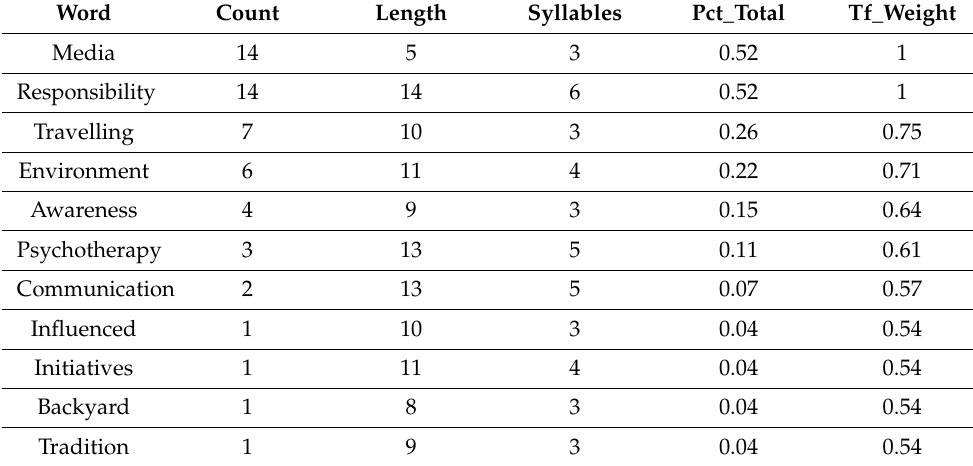
Table 8. Hard Words for Blog (Source: Advanced Text Analyzer).